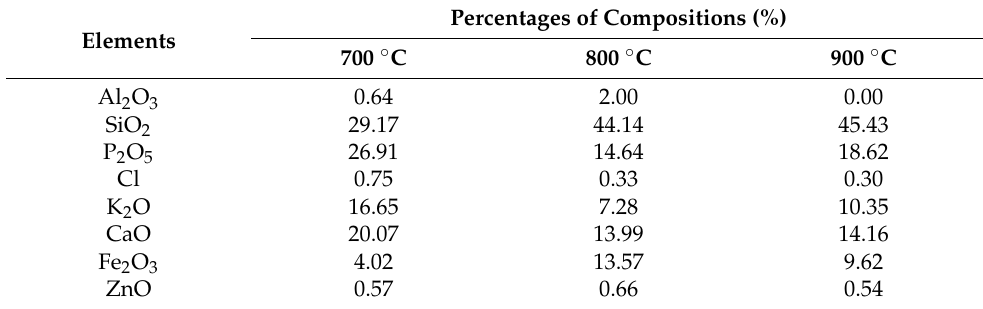
Table 1. Elemental composition of arecanut husk ash (AHA) at different sintering temperature.